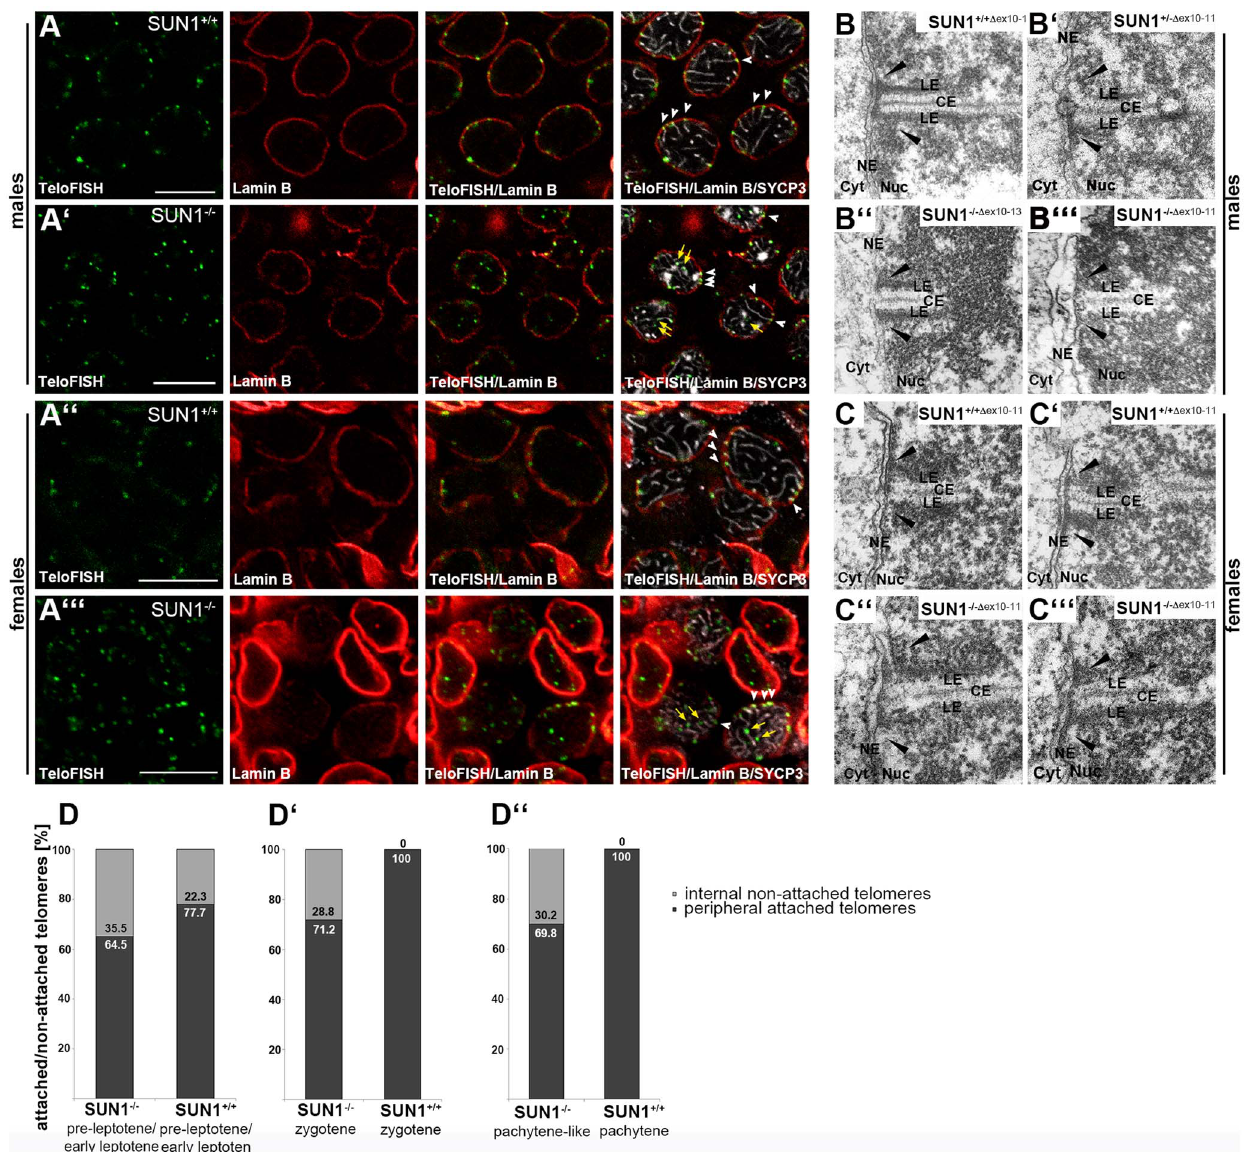
Figure 1. Presence of meiotic telomere attachment in Sun1 2 / 2 mouse strains. (A) Telomere fluorescence in-situ hybridization (TeloFISH) in co- localization with Lamin B and SYCP3 immunofluorescence on representative 15 dpp (days past partum) Sun1 + / + ( D ex10-11) and littermate Sun1 2 / 2 ( D ex10-11) testis sections (A, A 9 ) and 17.5 dpf (days past fertilization) Sun1 + / + ( D ex10-11) and littermate Sun1 2 / 2 ( D ex10-11) ovary sections (A 0 , A 90 ). In all WT sections investigated, attached telomeres appear embedded within the labeled lamina (white arrowheads in A and A 0 ). All sections from knockout tissues clearly showbothdetached,internaltelomeresignals (yellowarrows inA 9 andA 90 ) as wellas attached, peripheraltelomeresignals (whitearrowheads inA 9 andA 90 ) in bothoocytes andspermatocytes. Peripheral, attached telomeres in SUN1 deficient oocytes and spermatocytes are also seen at the ends of synaptonemal complex (SC) axes shown by SYCP3, as is the case in wildtype cells. Scale bar 10 m m. (B) Representative electron micrographs of spermatocytes from adult Sun1 + / + ( D ex10-13) (B) and Sun1 2 / 2 ( D ex10-13) (B 0 ) [11] mice and of spermatocytes from 15 dpp Sun1 + / 2 ( D ex10-11) (B 9 ) and Sun1 2 / 2 ( D ex10-11) (B 90 ) [21] mice. (C) Representative electron micrographs from E17.5 female Sun1 + / + ( D 10-11) (C–C 9 ) and Sun1 2 / 2 ( D 10-11) (C 0 –C 90 ) oocytes. In male wildtype meiocytes of both mouse strains andfemale wildtype meiocytes of the SUN1 ( D ex10-11) strain, components of the SC and the telomere attachment plates (black arrowheads) are clearly visible. Meiocytes from all Sun1 2 / 2 males (B 0 – B 90 ) as well as females (C 0 –C 90 ) also show the wildtype-like formation of telomere attachment sites. (D) Quantification of attached and non-attached telomeres in wildtype and knockout spermatocytes at different meiotic stages. Pre-leptotene/early leptotene spermatocytes from littermate 12 dpp mice (D), zygotene spermatocytes from littermate 12 dpp mice (D 9 ) and spermatocytes from littermate 14 dpp mice in a pachytene or pachytene-like stage, respectively (D 0 ). (12 dpp pre-leptotene/early leptotene: Sun1 + / + ( D ex10-11) n =16 spermatocytes, 772 telomeres; Sun1 2 / 2 ( D ex10-11) n =13 spermatocytes, 645 telomeres. 12 dpp zygotene: Sun1 + / + ( D ex10-11) n =5 spermatocytes, 194 telomeres; Sun1 2 / 2 ( D ex10-11) n =7 spermatocytes, 337 telomeres. 14 dpp pachytene: Sun1 + / + ( D ex10-1)1 n =54 spermatocytes, 2138 telomeres; pachytene-like Sun1 2 / 2 ( D ex10-11) n =31 spermatocytes, 1150 telomeres.) LE lateral element, CE central element, NE nuclear envelope, Nuc nucleoplasm, Cyt Cytoplasm.